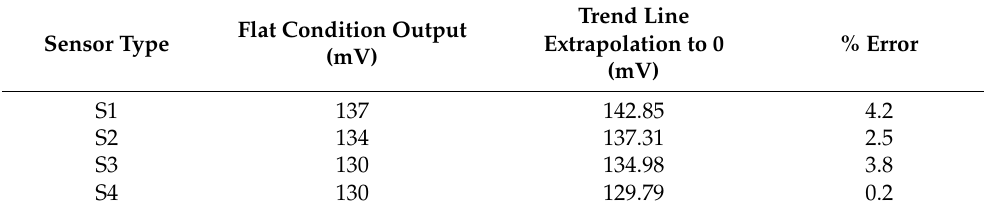
Figure 7. Comparison between sensors with as-cast, annealed, and twisted-annealed AF10 amor- phous wire, twisted 40 ◦ /cm (271 MPa torsion stress), magnetized in 0.9 kA/m magnetic field and 500 Hz frequency due to bending angle δ b . Table 2. Comparison between the sensor in flat condition and trendline extrapolation to 0°.